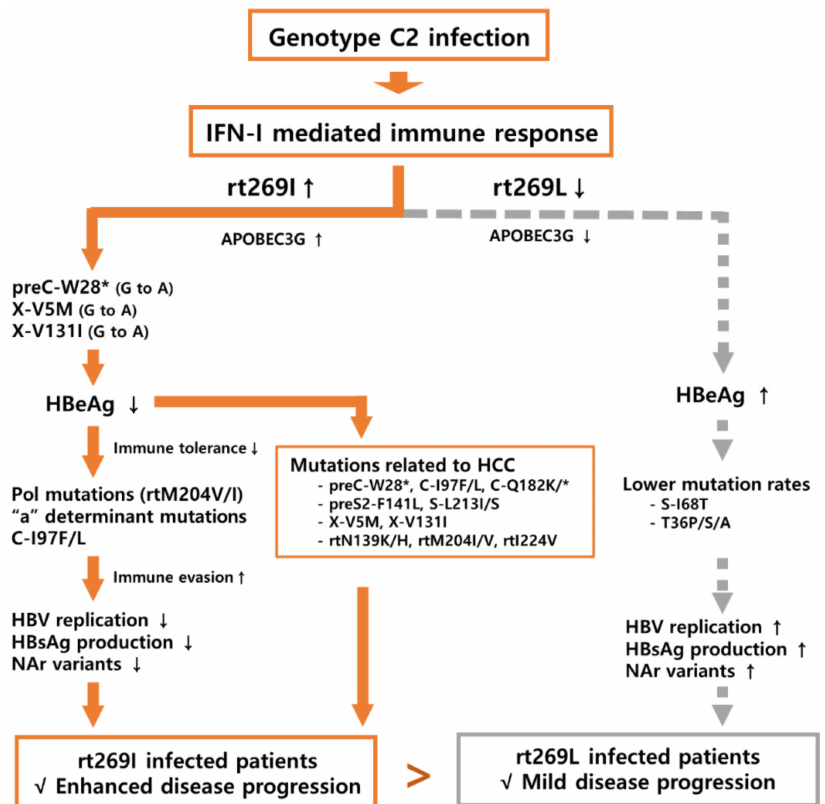
Figure 5. Schematic presentation. Schematic image showing that rt269I type versus rt269L type is more prone to overall genome mutations, particularly in the Pol and MHR regions in genotype C2 infections. The signature nonsynonymous mutations can contribute to the decreased level of HBV DNA replication, HBeAg secretion, NAr variants, and HCC occurrence. Finally, rt269I type versus rt269L type can lead to liver disease